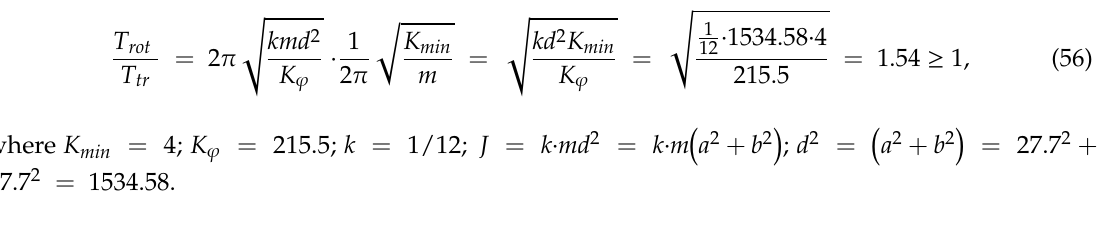
Table 15. Ratios of the modal participating mass. Mode